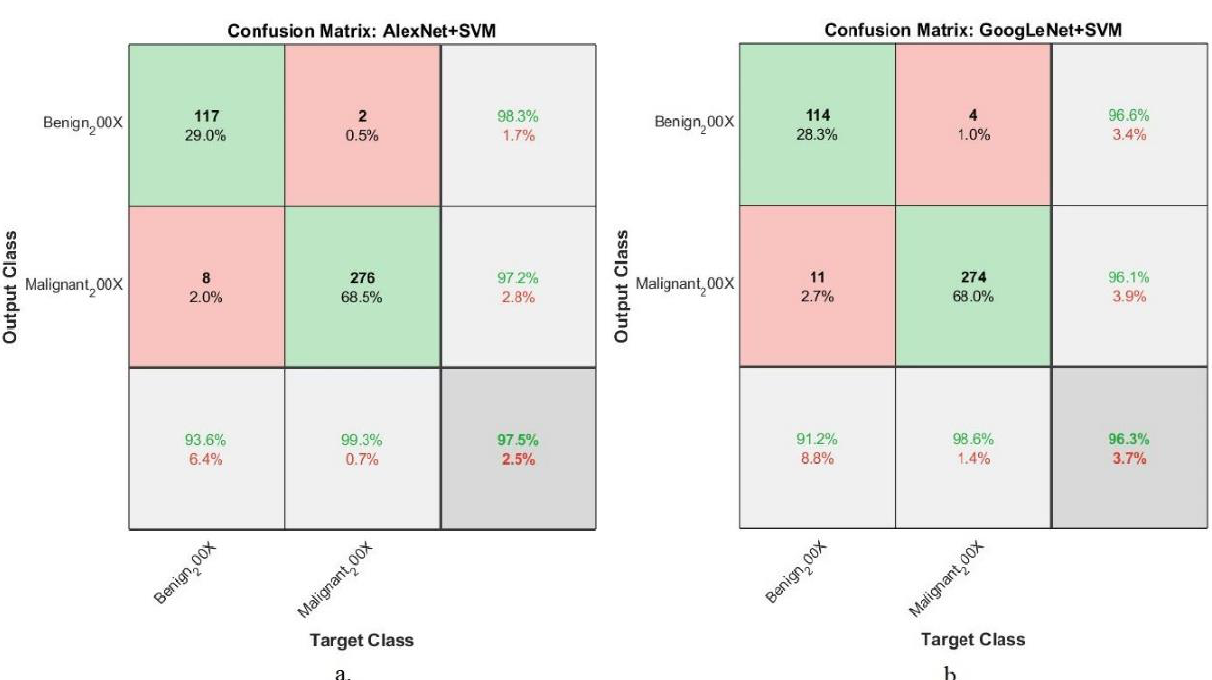
Figure 8. Evaluation of a BC dataset with a magnification of 200× by the confusion matrix produced by ( a ) AlexNet + SVM and ( b ) GoogLeNet + SVM. by ( a ) AlexNet + SVM and ( b ) GoogLeNet +